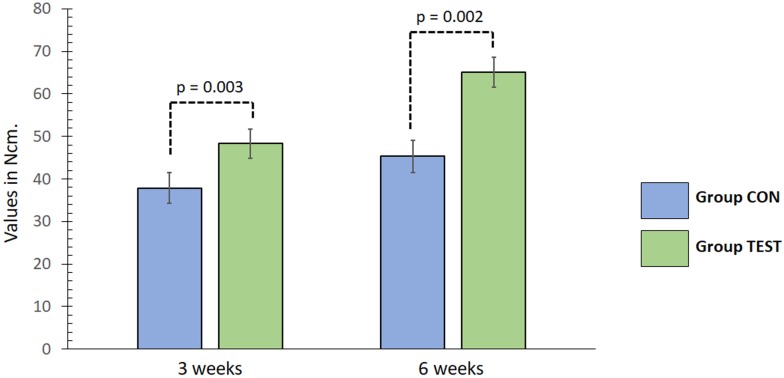
Bar graph showing the RTv values, standard deviation and statistical comparison on the two times of both groups.